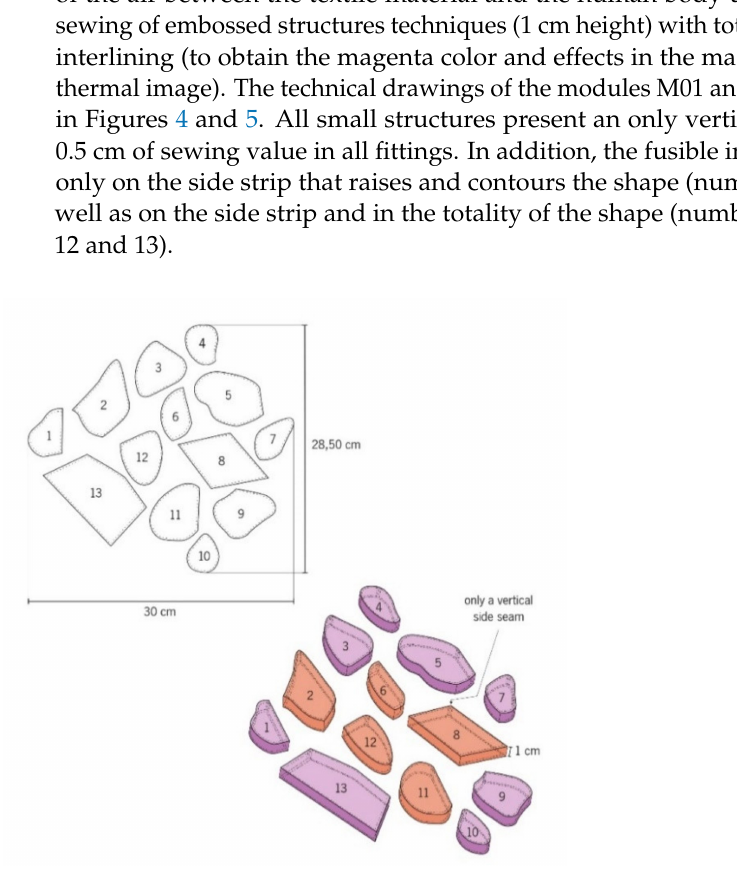
Figure 4. Technical drawing of the embossed structures of the pattern module M01.